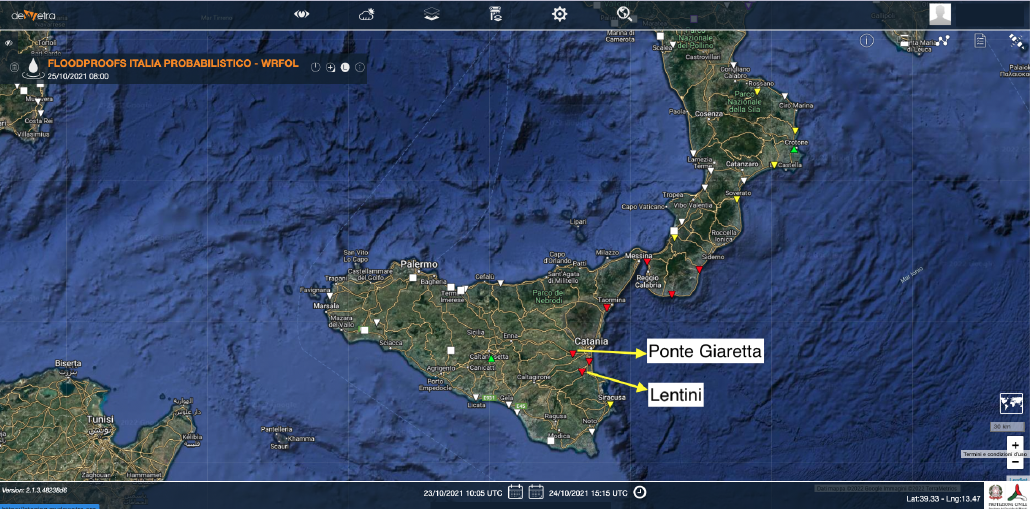
Figure 5. FloodPROOFS forecast over southern Italian rivers sections. Visualization on MyDewetra platform. The different sections’ colors refer to the magnitude of the peak discharge with respect to the fixed threshold for alarm (yellow) and alert (red). Green and white colors refer to discharge increasing but still below thresholds and discharge not increasing or decreasing, respectively.